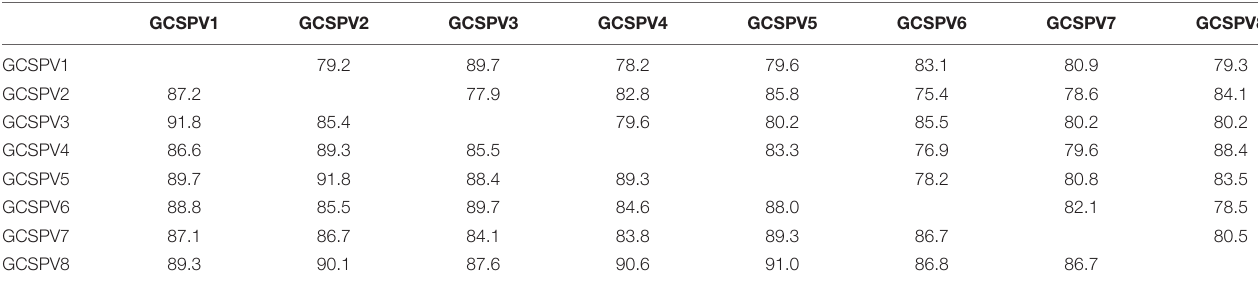
TABLE 3 | Identities of the nucleotide and amino acid sequences of the coat protein region (705 bp) between the sequence variants (SV) of ASPV found in N. occidentalis and apple seedlings inoculated with the RNA transcript of ASPV from AGCD-apple. GCSPV1 GCSPV2 GCSPV3 GCSPV4